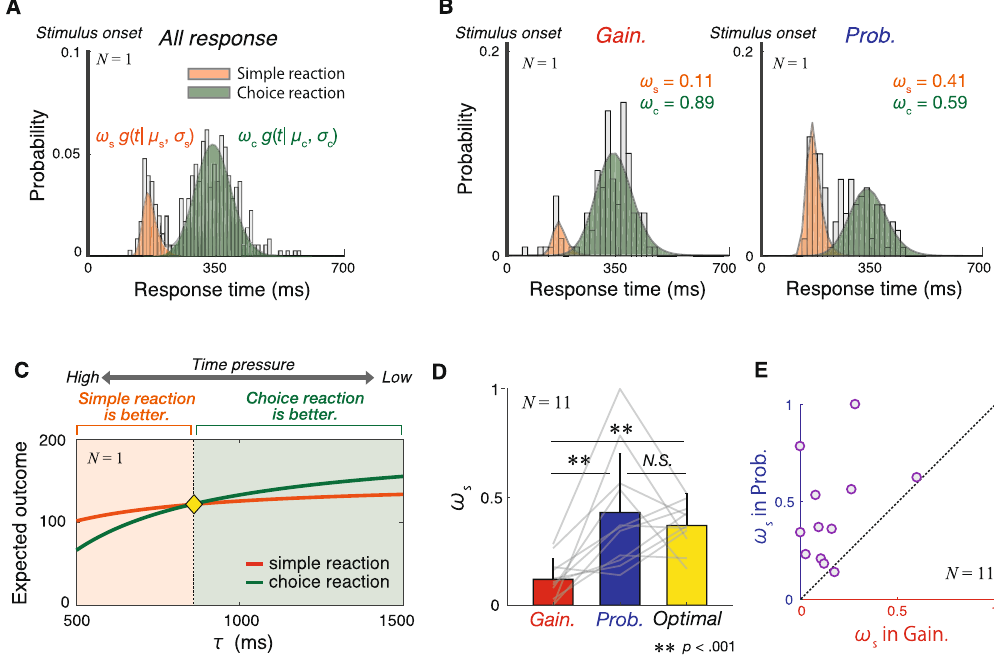
Figure 4. Evaluation of the optimality of response-strategy selection. ( A ) Gaussian mixture model (GMM) fitting. The gray histogram indicates the response time distribution of an individual participant (including all response data). The orange and green shaded areas show two components of Gaussian distribution estimated by GMM. The orange and green components indicate a simple reaction pattern and choice reaction pattern, respectively. The figures for each participant are shown in Supplementary Fig. 5. ( B ) GMM for each condition. The upper and lower panels show response time distribution in the gain and probability-decrease conditions, respectively (based on data from the same participant depicted in Fig. 4B). The orange and green shaded areas indicate the components of Gaussian distributions determined by the ratio of simple reaction pattern in each condition ( ϖ − or ϖ − ) which was fitted to observed data. The figures for each participant are shown in s gain s prob ϖ . The orange and green lines Supplementary Fig. 6. ( C ) Estimation of optimal weighting of the simple reaction s indicate the expected gain of simple and choice reaction patterns corresponding to τ , respectively. The yellow diamond shows the point of indifference between response patterns, indicating the optimal switching point. The figures for each participant are shown in Supplementary Fig. 7. ( D ) Comparison of weighting of the simple reaction. The bars show mean ϖ in each condition and mean optimal ϖ among participants. The thin gray lines s s indicate individual data. There were significant differences in the weighting of simple reaction patterns in the ϖ gain-decrease condition _ s gain bias of response-strategy selection was highly consistent among